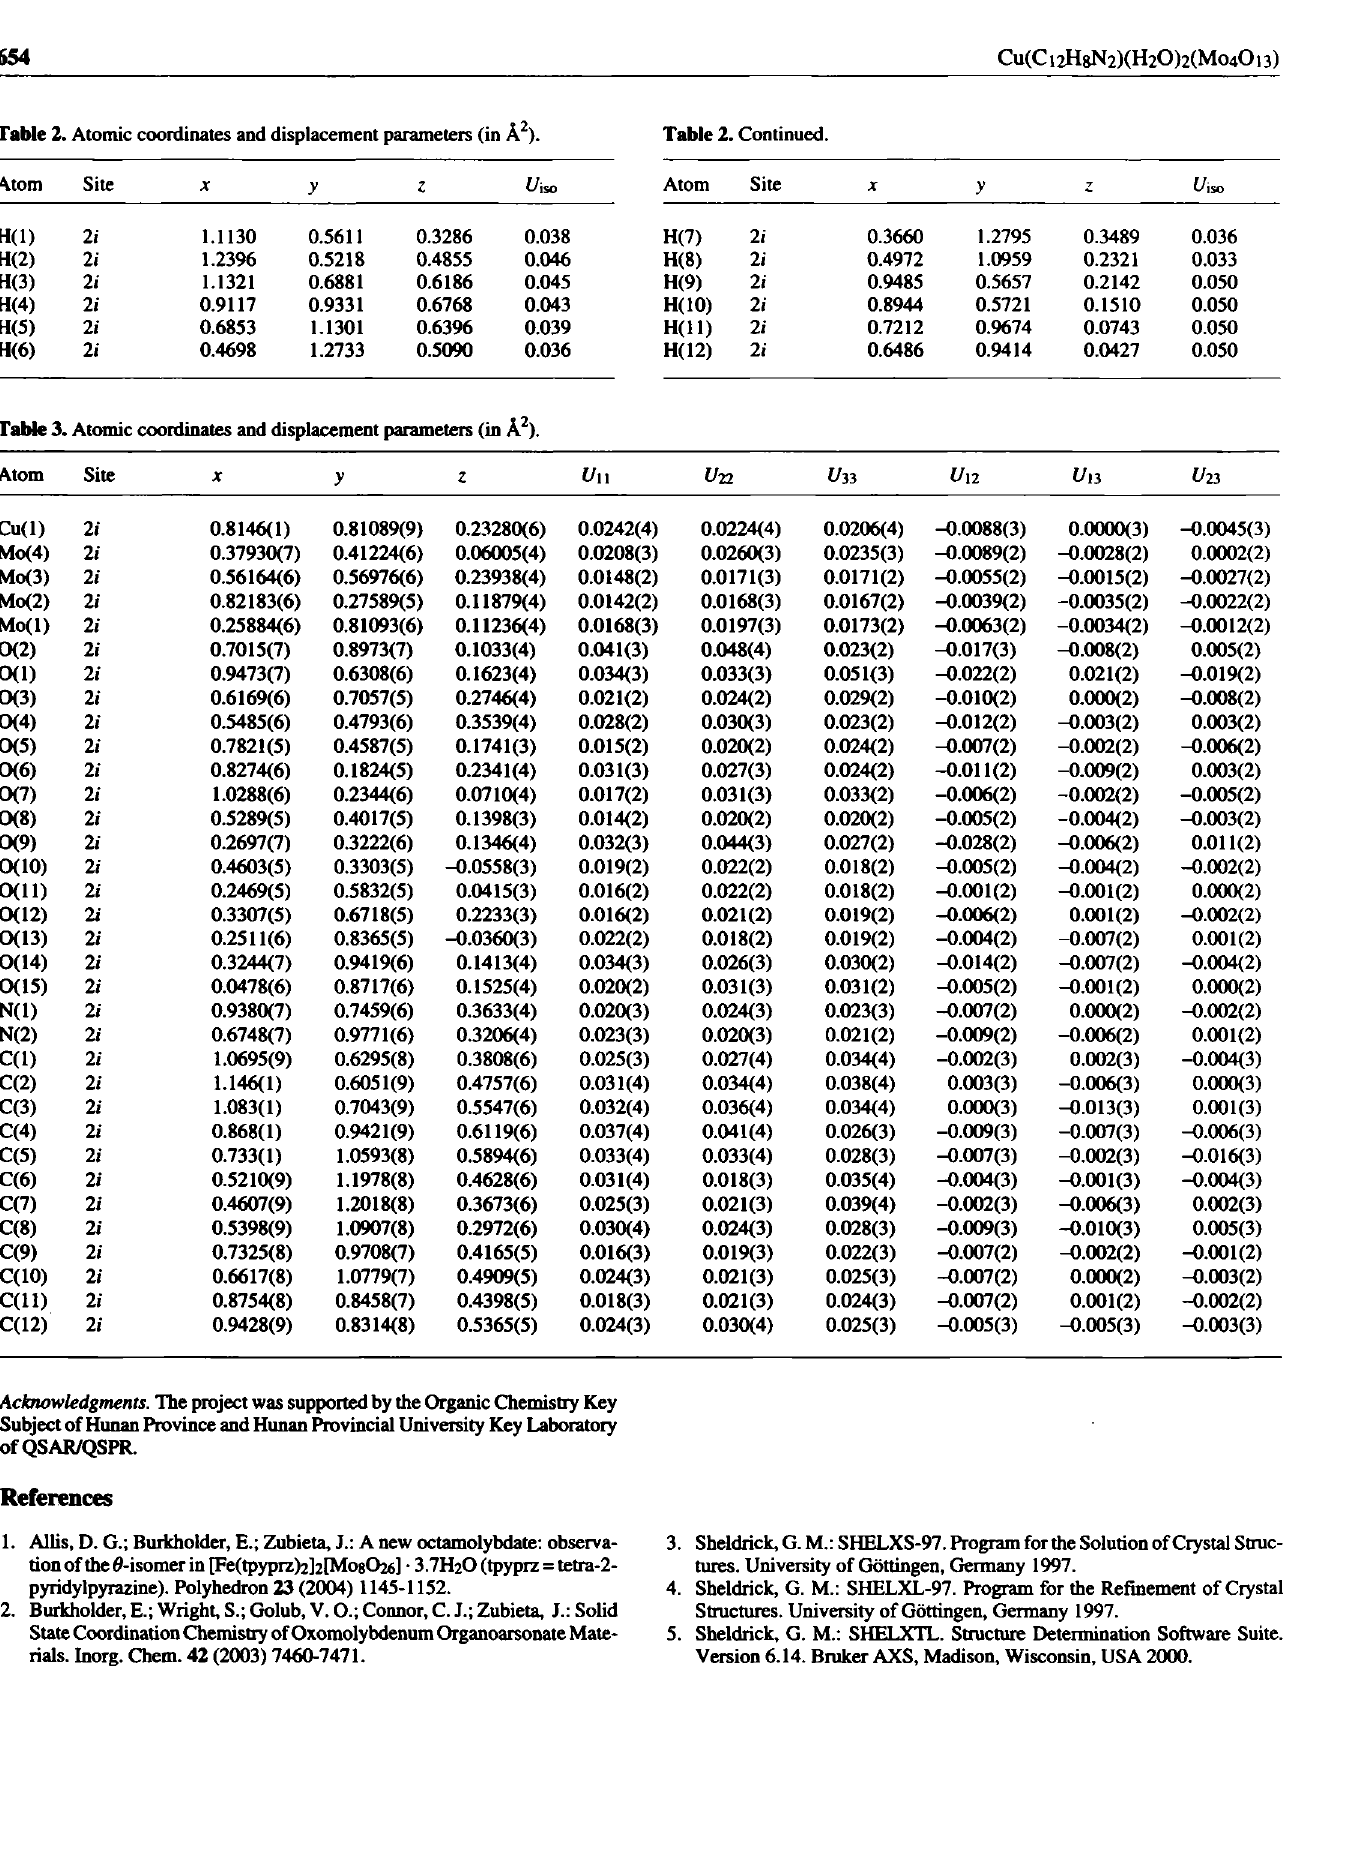
Table 2. Atomic coordinates and displacement parameters (in Â 2 ). Table 2. Continued.